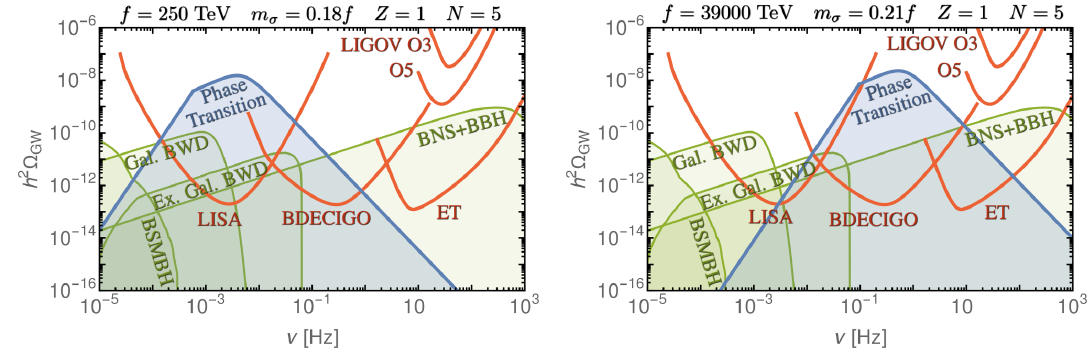
Figure 8 . The stochastic gravitational wave background sourced by the bubble collisions following the supercooled phase transition for the two benchmark points. Foregrounds due to super-massive black hole, galactic and extragalactic white dwarf, neutron star, and black hole binaries are also shown [202, 207, 208]. Foreground subtraction techniques continue to be developed [208–215]. The power-law integrated sensitivity curves SNR = 10 , defined in eq. (5.5), of various current and future detectors are also shown, constructed using the projected sensitivities described in the